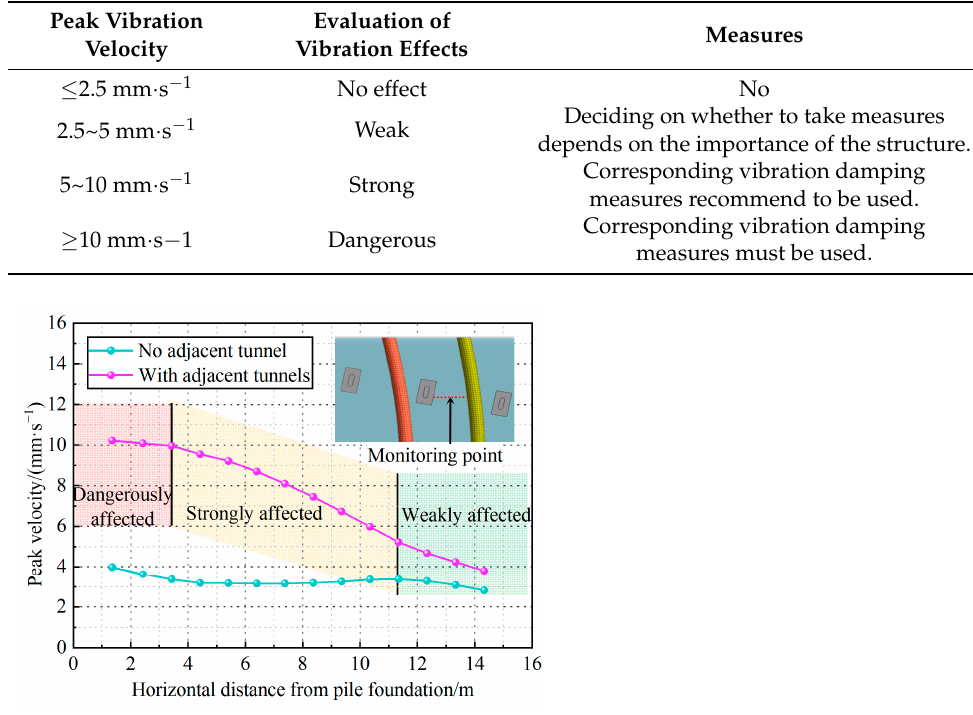
Table 4. Graded control thresholds for the dynamic response of underground structures.